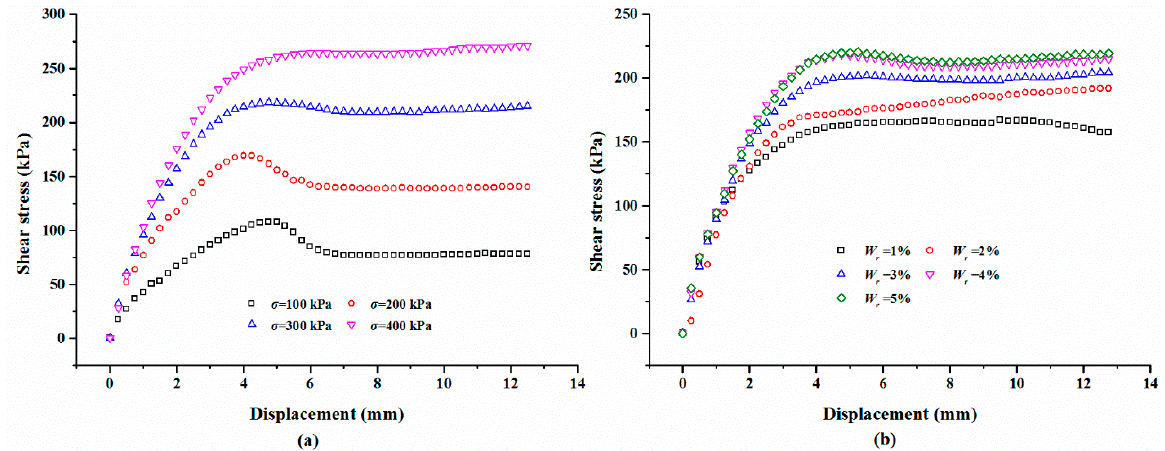
Figure 11. The typical shear curves: ( a ) With different normal stress σ ; ( b ) With different polymer content W r .